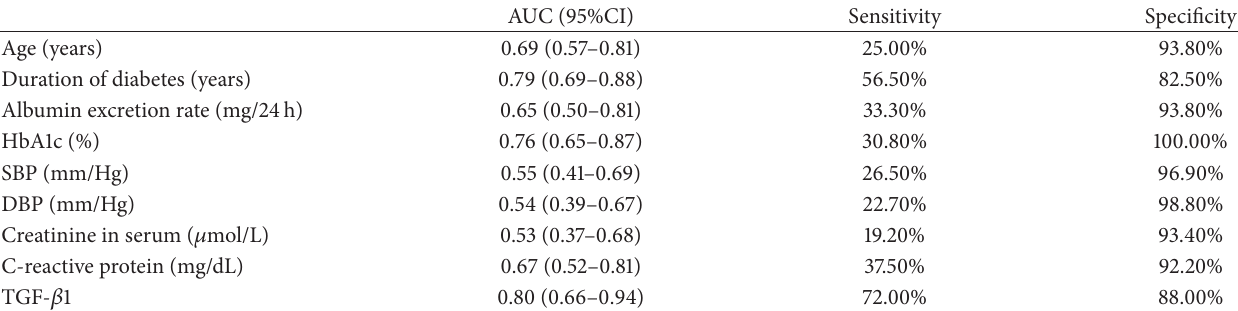
Table 3: AUC analysis of the studied parameters in juvenile patients with ROC